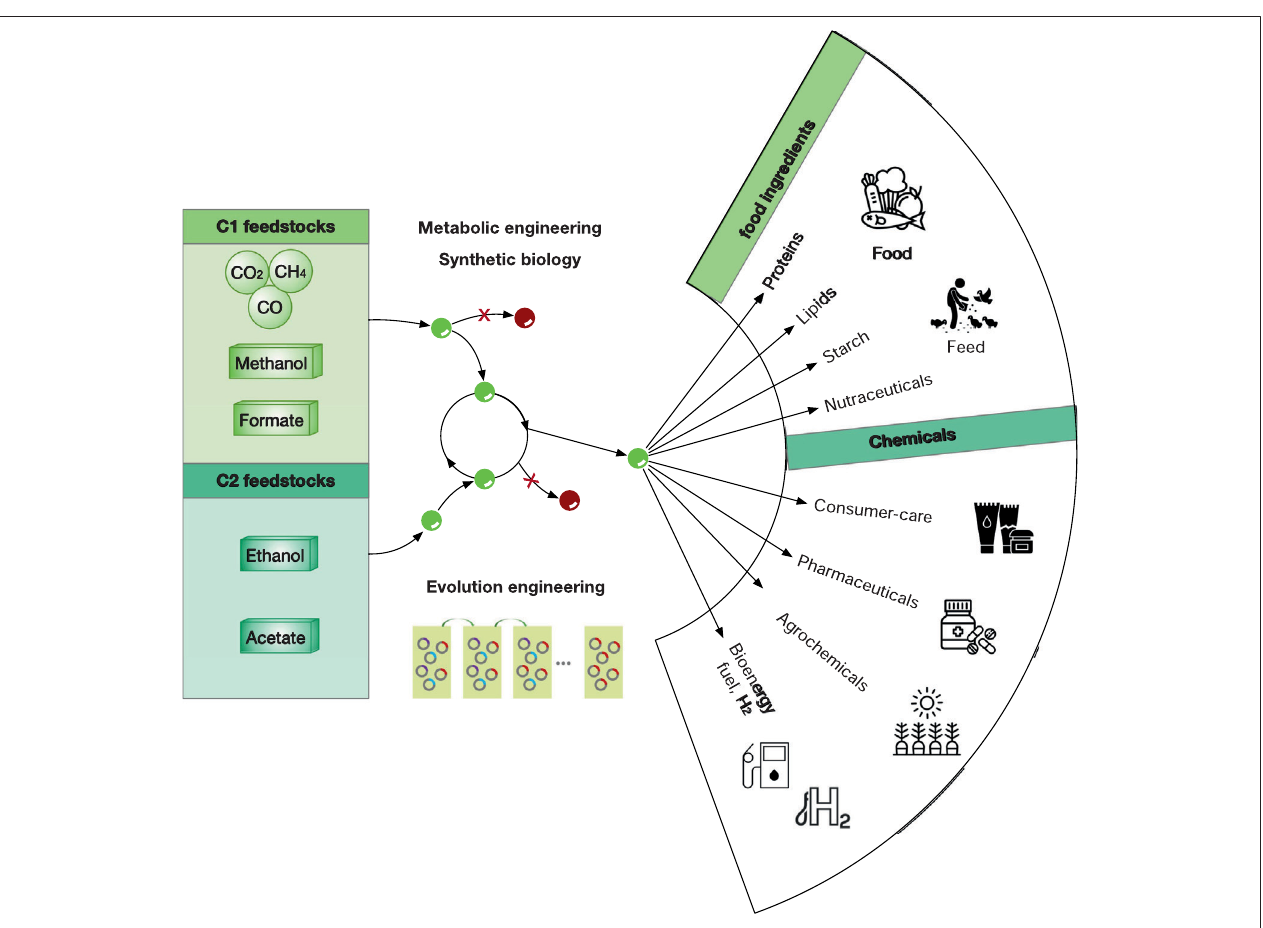
FIGURE10| TheoverviewofthebioeconomyusingC1andC2feedstocks.Gaseousfeedstocks(CO 2 ,CO,H 2 )areincircles,liquidfeedstocks(methanol,formate, ethanol and acetate) are in boxes. Green and red dots refer as intermediate metabolites and by-products. Metabolic engineering strategies include deleting the competing pathways to eliminate/minimize by-products. Elution engineering refers that the mutant strains with higher fi tness (rings in red) will gradually dominate in the fermentation medium supplemented with unfavorable NGFs.